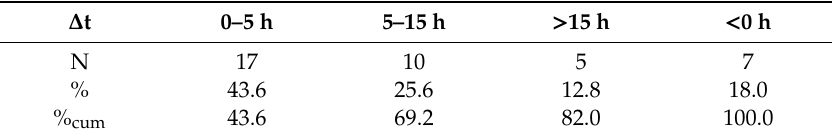
Table 2. Classification of the spring-autumn events based on the period (t, in h) between the time of the maximum recorded peak of rainfall intensity and the time of landslide occurrence. For each temporal break, we estimated the number of events (N), the percentage respect the total events (%), and the cumulated percentage (%cum) that represents the percentage of landslides occurred in temporal break interval added to the previous ones. ∆ t < 0 h represents the antecedent period to maximum rainfall